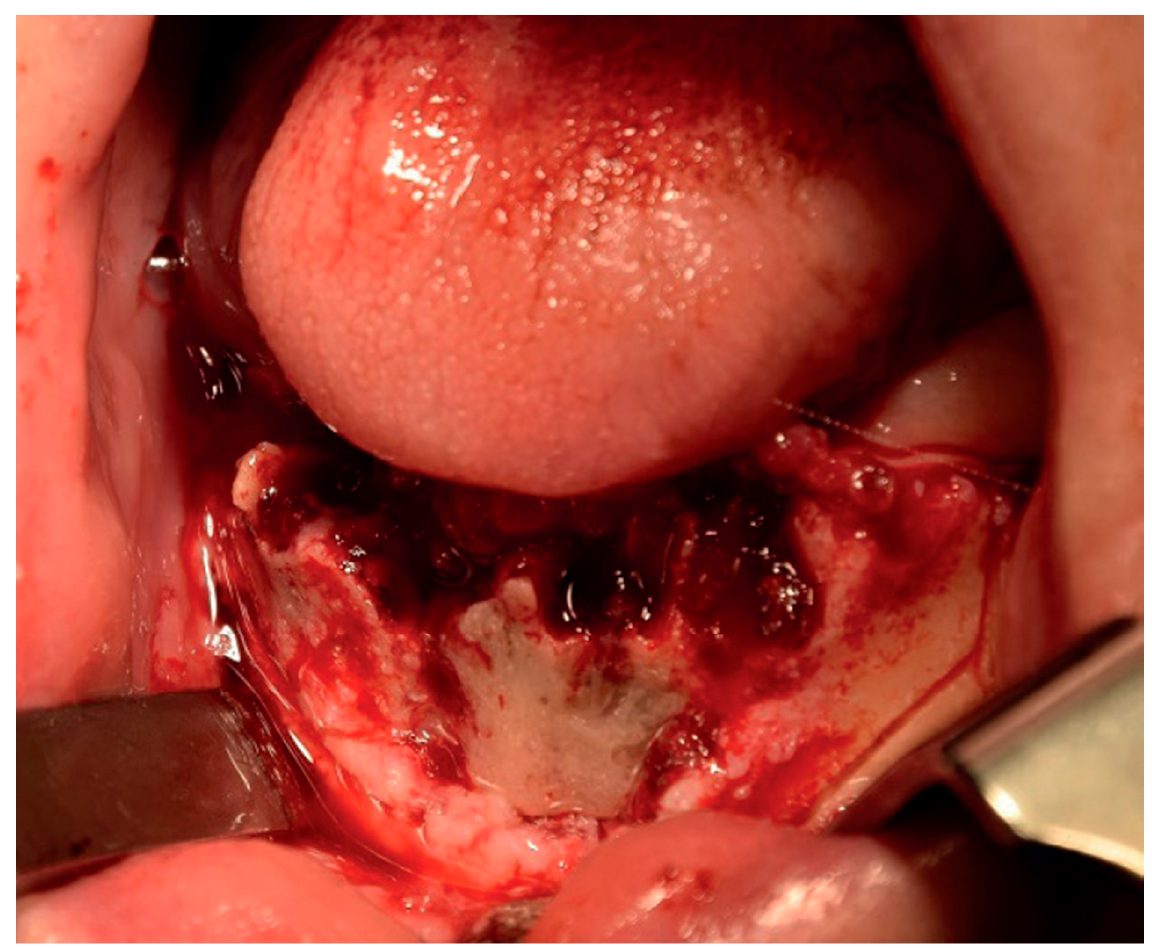
Figure 4. Intraoperative view. Osteonecrosis of the mandible in the anterior region.